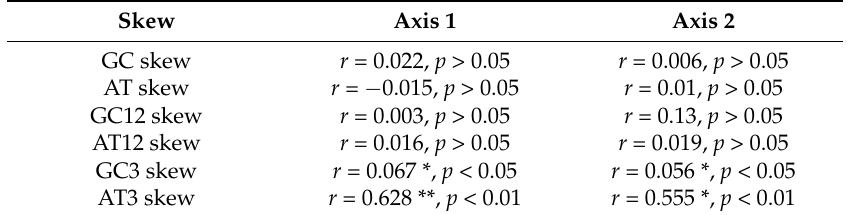
Table 2. Nucleotide composition statistics for a gene population in five S. agalactiae genomes. Skew Axis